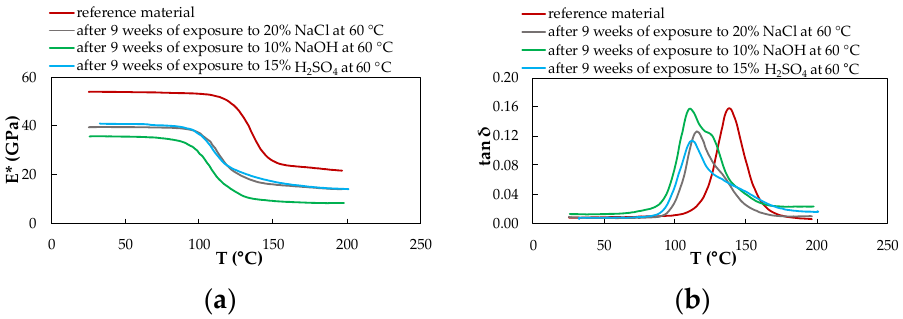
Figure 13. DMA of the CFRP composite evaluated depending on the influence of individual chemical environments at 60 °C; ( a ) complex modulus of elasticity; ( b ) tan delta.